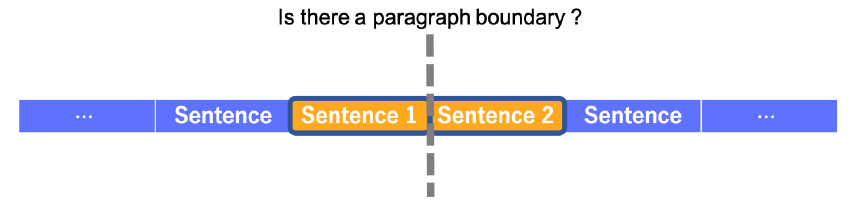
Figure 2. An illustration of paragraph-boundary recognition, which is a task to identify whether a paragraph boundary exists between any two consecutive sentences in a novel. Let two target sentences be Sentence1 and Sentence2